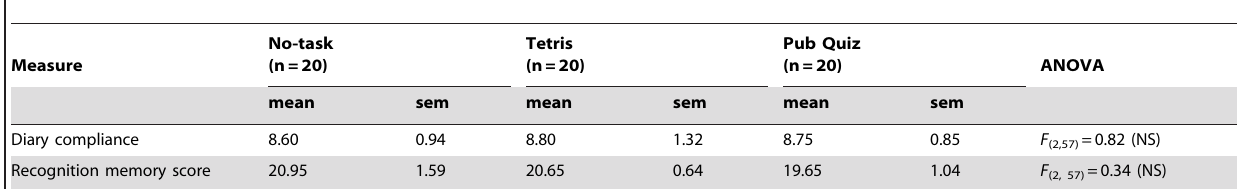
Table 5. Experiment 1 diary compliance and recognition memory after 1-week indicating equivalence across conditions.